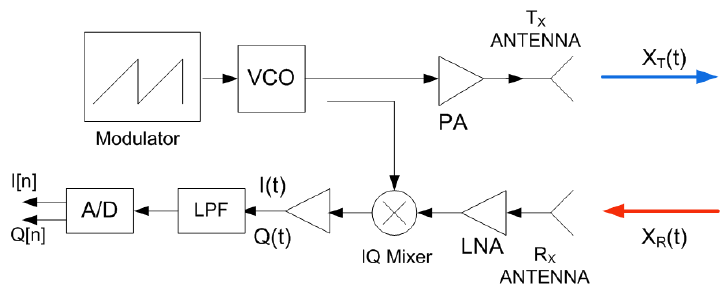
Figure 3. Block diagram of a generic FMCW radar used in the analysis.